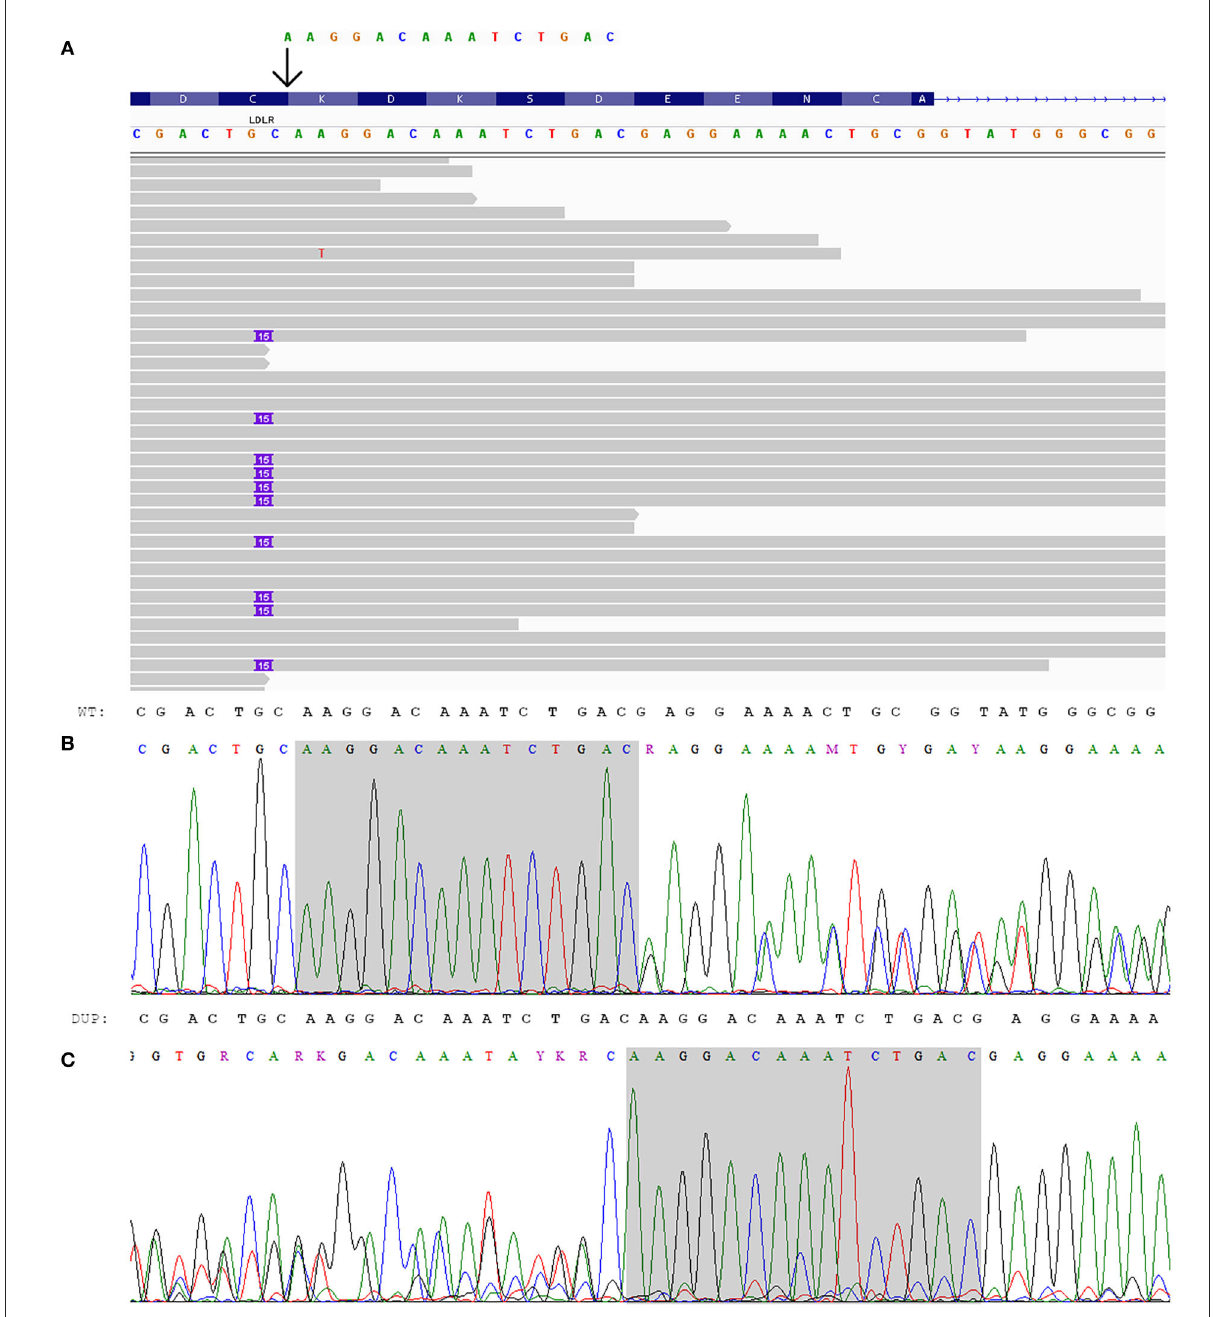
FIGURE2 Genetic analysis of the index patient. (A) Integrated genome view of LDLR -p.K223_D227dup with IGV (12). (B, C) Electropherograms of LDLR -p.K223_D227dup: (B) sequence from the forward primer, (C) sequence from the reverse primer (reverse complement).